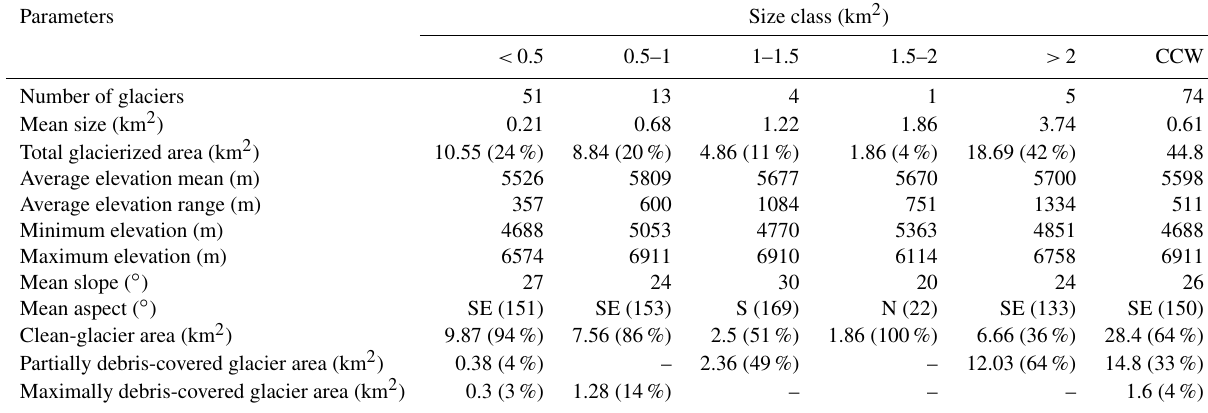
tabulated in Table